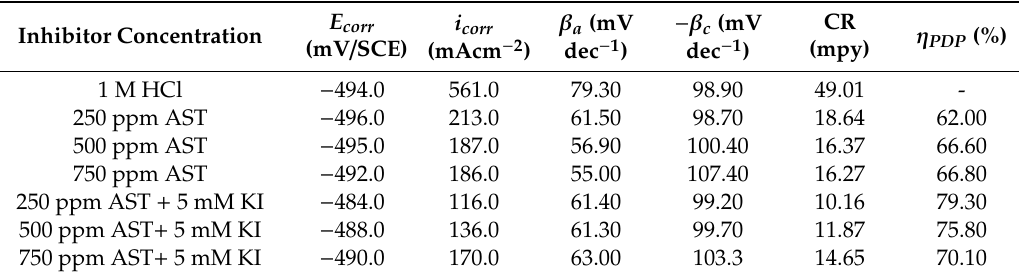
Table 2. Potentiodynamic polarization parameters for C1018 carbon steel in 1 M HCl and various concentrations of AST and AST + KI at 25 ◦